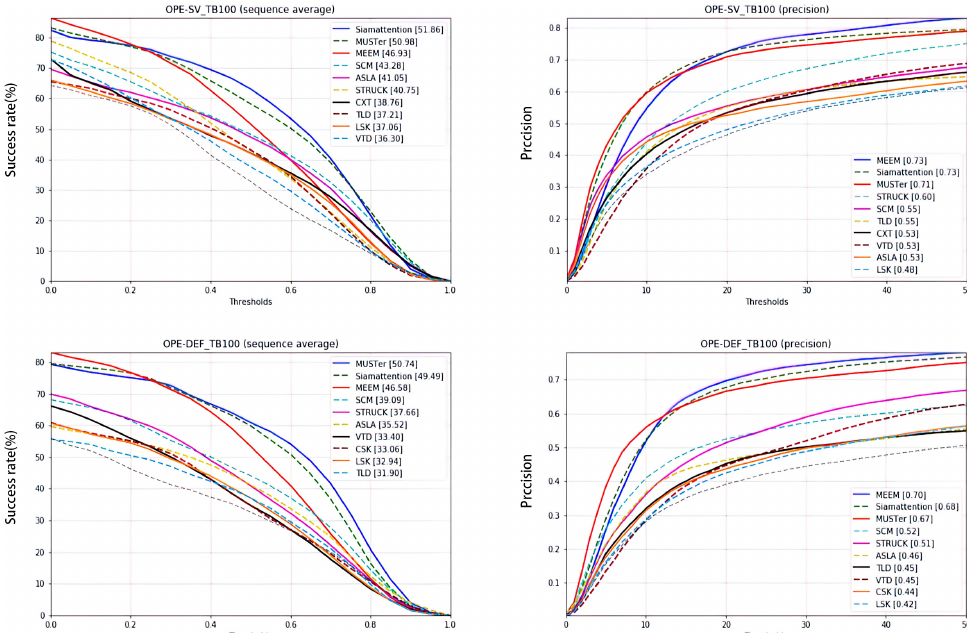
Figure 7. Success plot and precision plot of SV, DEF, IPR, and OPR under SV conditions. The proposed tracker is shown as the solid blue line in the success plot, ranking first, and the green virtual line in the precision plot, again ranking first. Under DEF conditions it is shown as the green dotted line, ranking second.